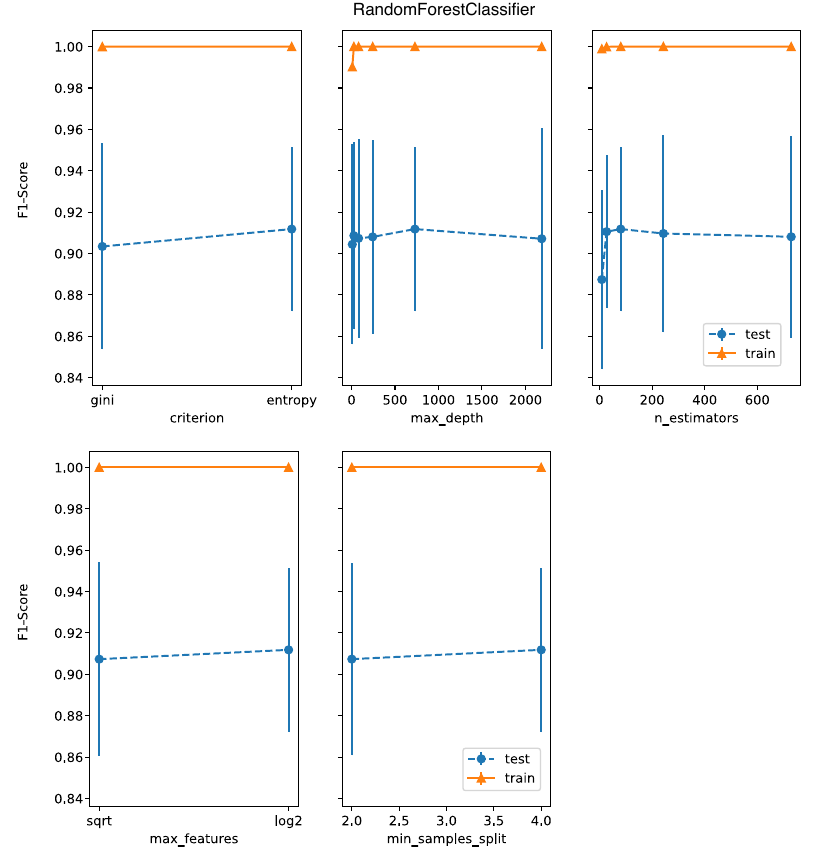
Figure 4. Mean performance of Random Forest models for respective evaluated hyperparameters with standard deviation.